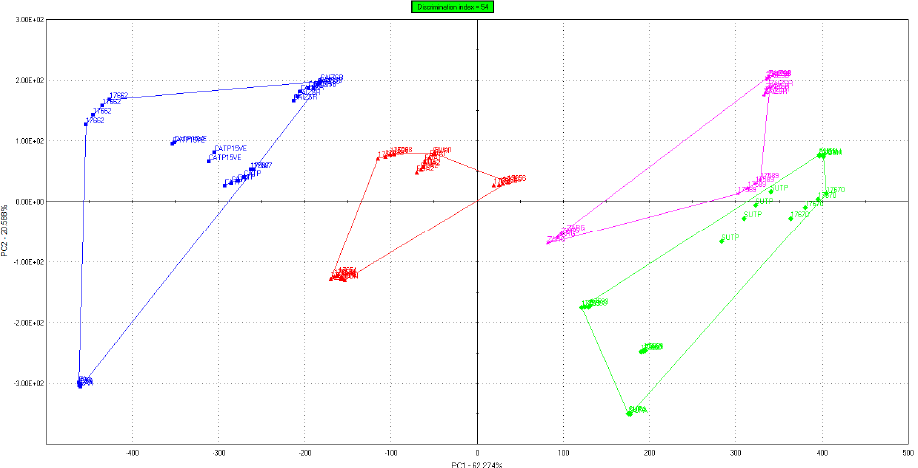
Figure 2. Principal component analysis (PCA) obtained for the different honey varieties. The coloured straight lines indicates the boundaries of each group.